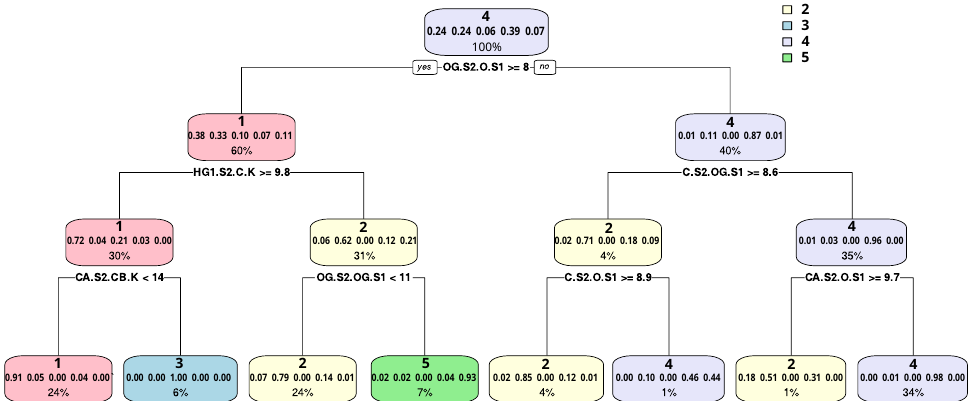
Figure 12. Classification tree to separate conformational clusters using interatomic distances. Nodes list (in rows) the dominant cluster for points beneath the node, a fraction of points in each cluster beneath the node, and the fraction of the data set beneath the node. A small number of key distances approximately characterize the cluster